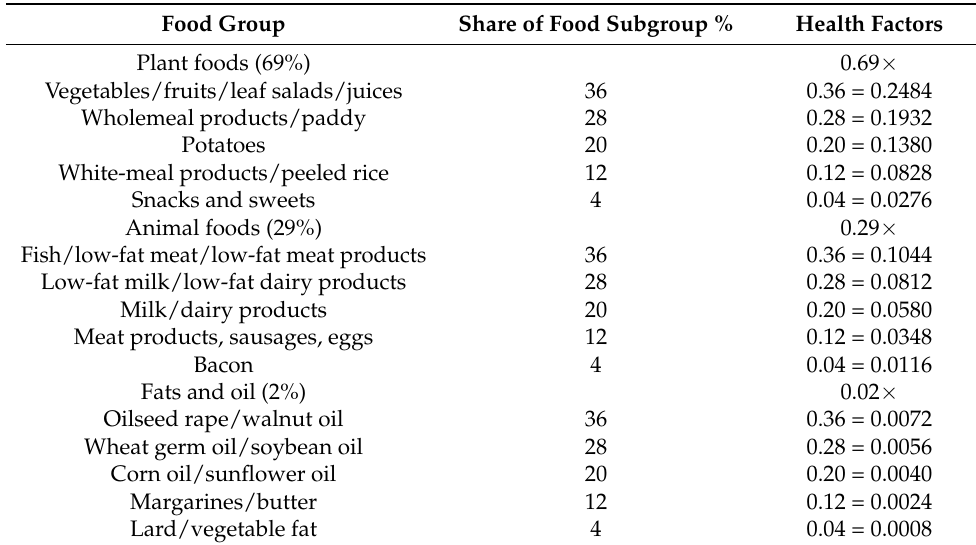
Table 1. Health factors for 15 food groups derived from the nutrition circle and the food pyramid of the CDG